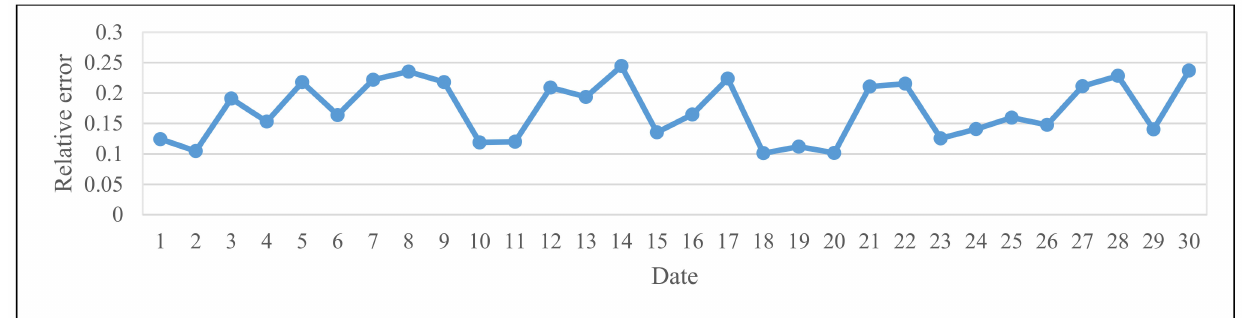
Figure 7. Relative error of cash flow forecast of G company in May 2019.